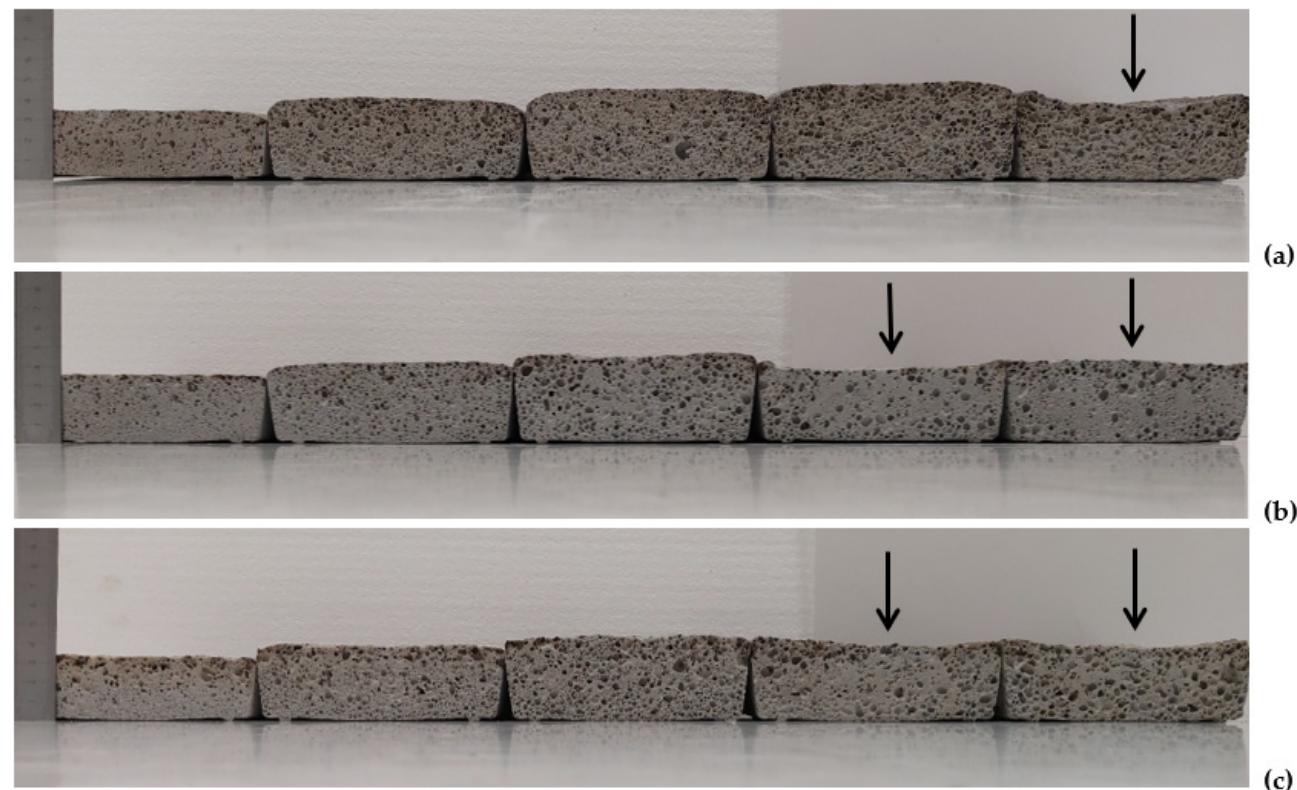
Figure 6. Expansion mode with Al powder content from (0.009 w.%, left) to (0.05 w.%, right); ( a ) P1 with 40% cork, ( b ) P2 with 10% cork and ( c ) P3 with 10% cork.